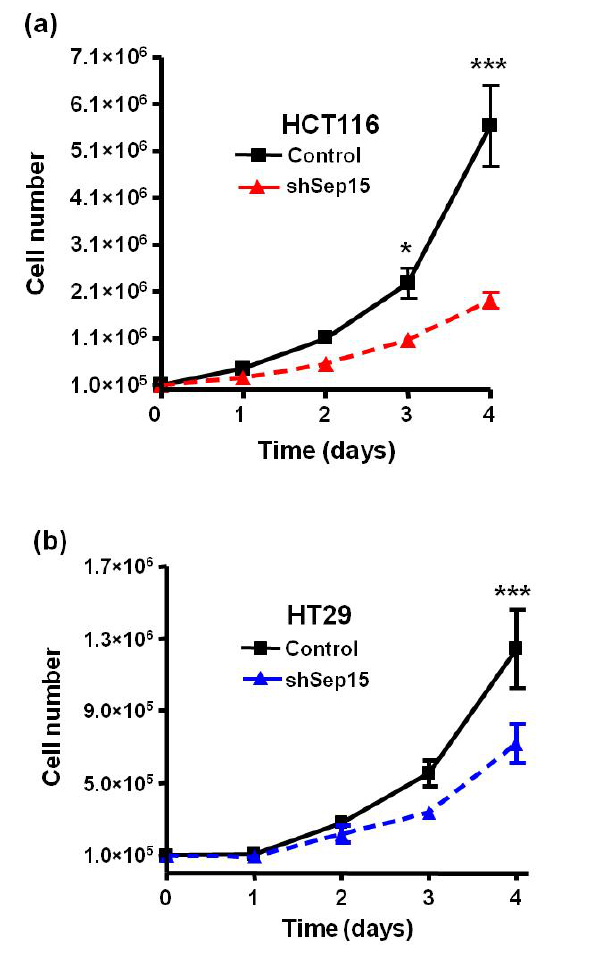
Figure 3. Effects of Sep15 deficiency on cell growth over a four day period